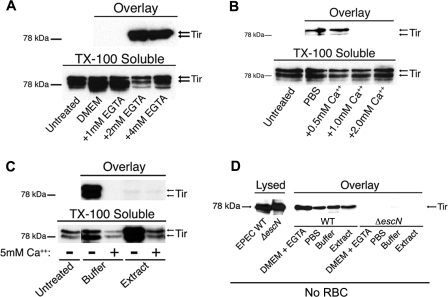
Decreased Ca++ Induces Rapid Release of Tir from EPEC(A) Western analysis of RBC infected with EPEC and exposed to either normal DMEM (2 mM Ca++) or DMEM supplemented with 1 to 4 mM EGTA. Both the Overlay and TX-100 soluble fractions were probed with anti-Tir antibody.(B) Western analysis of RBC infected with EPEC and exposed to either Ca++-free PBS or Ca++-free PBS supplemented with 0.5 to 2 mM CaCl2. Both the Overlay and TX-100 soluble fractions were probed with anti-Tir antibody.(C) Western analysis of RBC infected with EPEC and either left untreated, or exposed to buffer or extract with or without the addition of 5 mM CaCl2. Both the Overlay and TX-100 soluble fractions were probed with anti-Tir antibody.(D) Western analysis of wild-type EPEC (WT) and EPECΔescN cultured in DMEM for 6 h in the absence of RBC and either lysed with SDS-PAGE sample buffer to verify Tir expression (lanes 1 and 2), or exposed to either DMEM + 4 mM EGTA, Ca++ free PBS, buffer or extract to induce Tir secretion (WT; lanes 3–6, ΔescN; lanes 7–10). Both the lysed bacteria and the Overlay fraction were probed with anti-Tir antibody. Note that although EPECΔescN contained large amounts of Tir when lysed, no secreted Tir was evident following exposure to low Ca++ conditions.